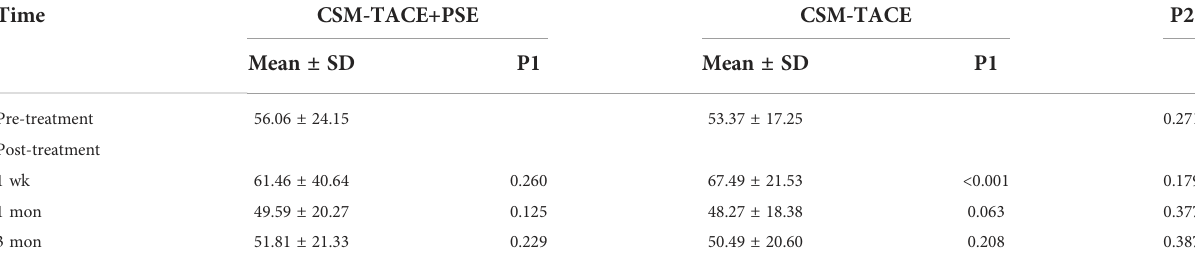
TABLE 6 Follow-up results of aspartate aminotransferase (AST) counts